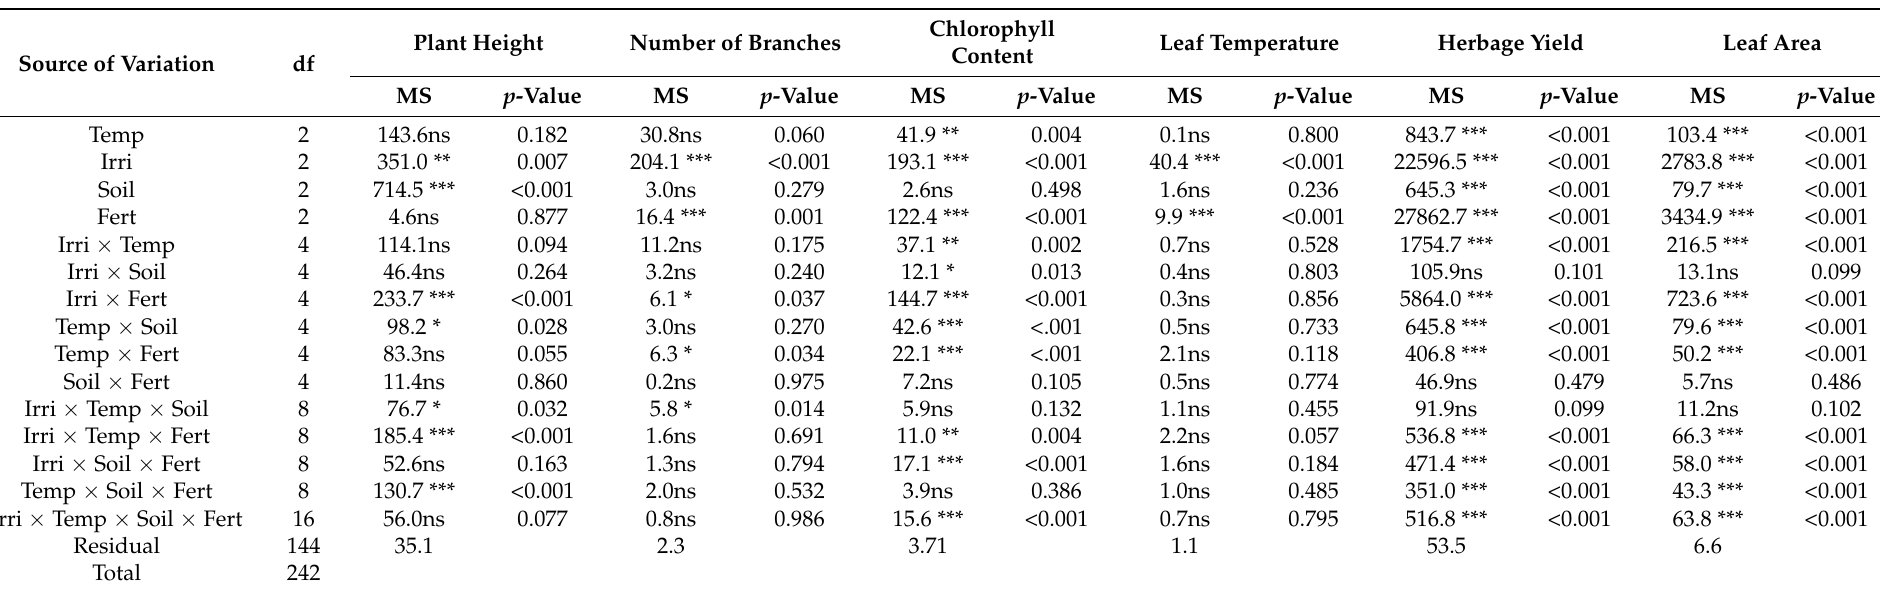
Table 1. Analysis of variance for the effect of air temperature and irrigation regimes, nitrogen application rate, and soil type on plant height, number of branches, leaf chlorophyll content, leaf temperature, herbage yield, and leaf area of marjoram